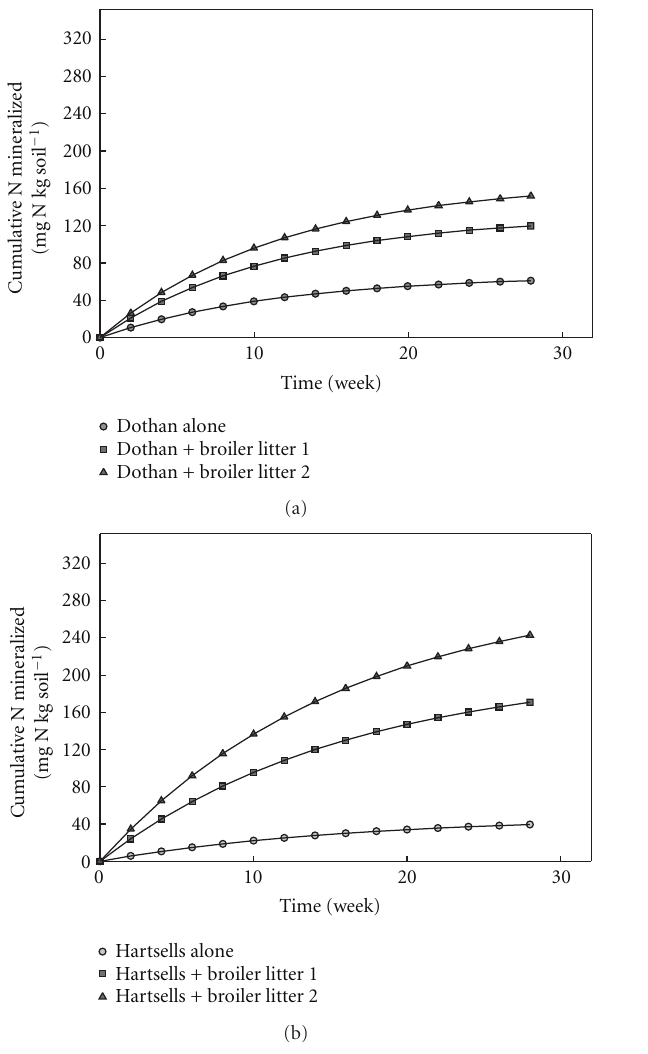
Figure 4: Cumulative organic nitrogen mineralized from Linker (a) or Maytag (b) soils amended with broiler litter 1 or 2 and incubated for 28 weeks under aerobic